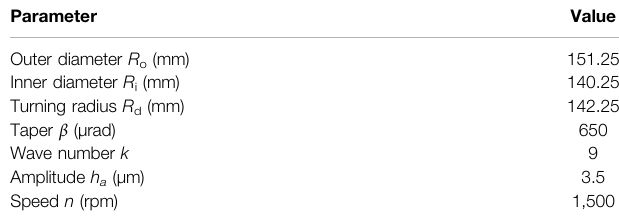
TABLE 1 | Geometric parameters of hydrostatic seal (Liu et al.,